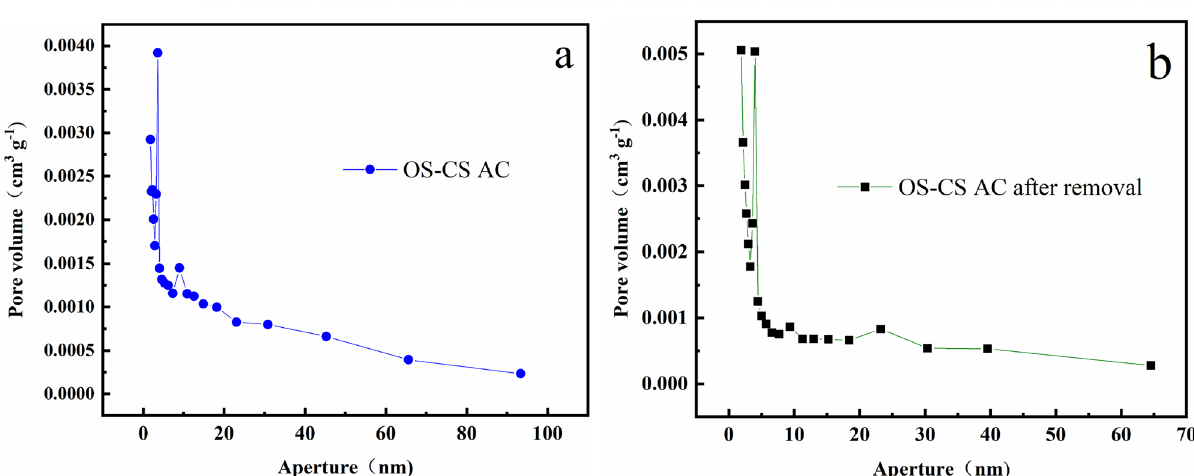
Figure 5. N 2 adsorption–desorption curves of ( a ) OS-CS AC and ( b ) OS-CS AC after removal of Cr(VI).